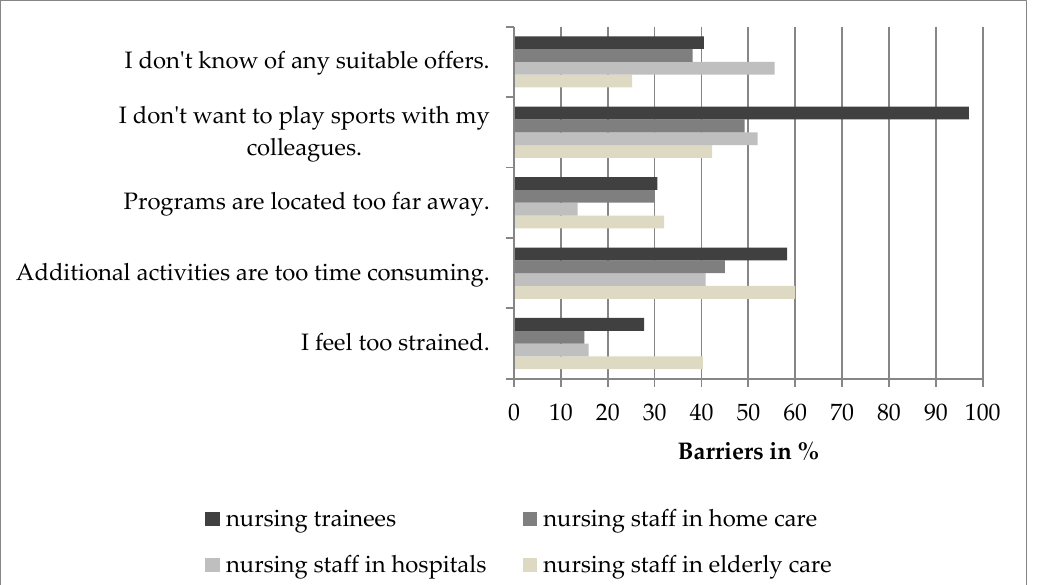
Figure 3. Barriers for participating in health promotion programs (multiple selections allowed). The control for gender differences did not show any effects.